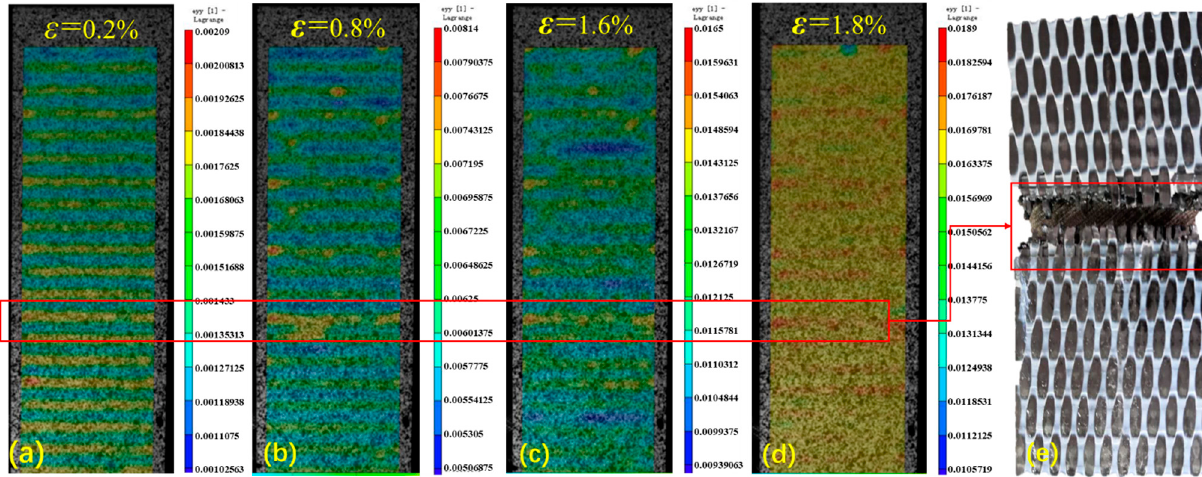
Figure 5. Full field strain maps at different strain levels ( a – d ) and the top view of the specimen fracture planes ( e ). Table 2. Mechanical properties generated from Step 1.